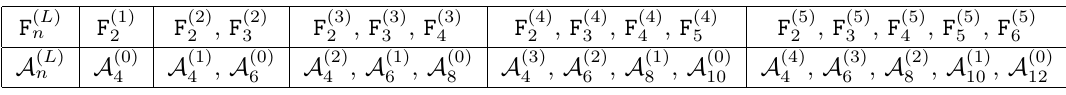
Table 1 . Cut integrands and scattering amplitudes required to compute F ( L )